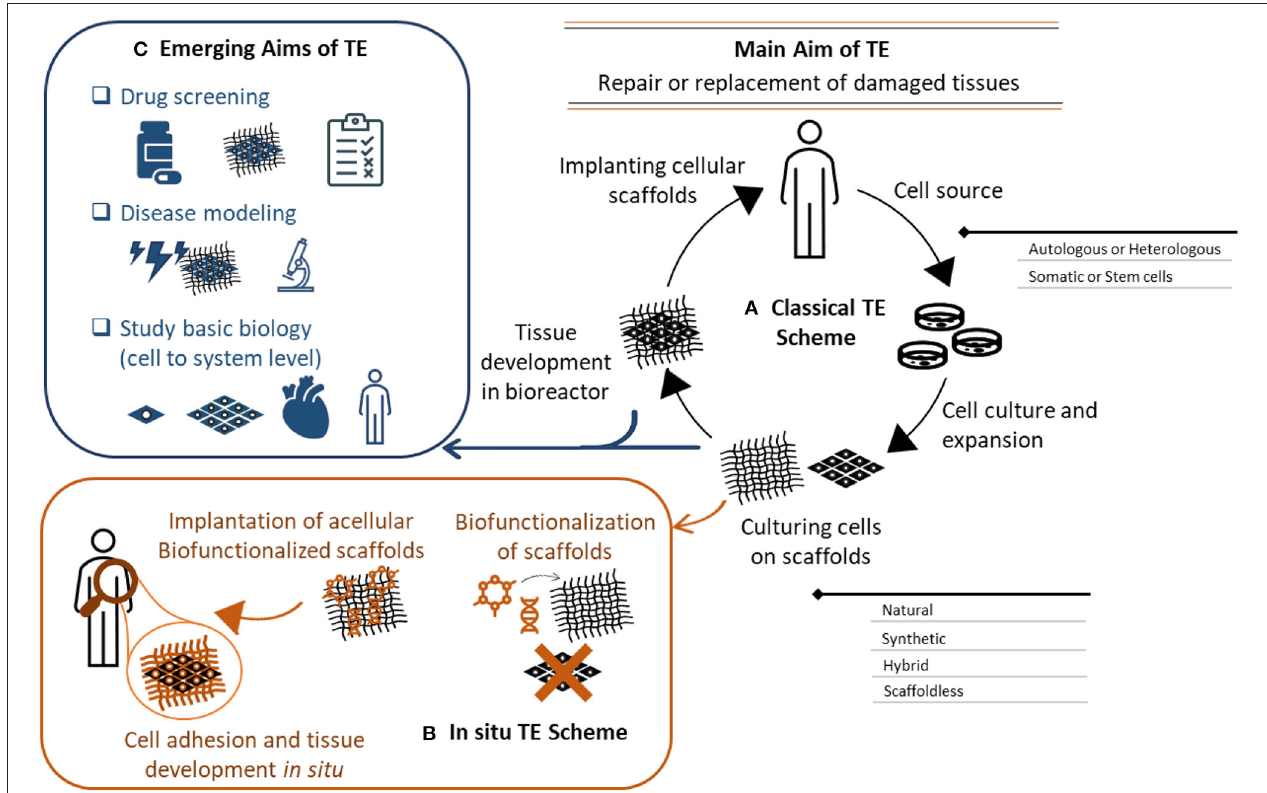
FIGURE 1 | Tissue engineering aims, concept, and evolution. (A) Classical in vitro tissue engineering (TE) relys on the use of a cell source (autologous or heterologous), cultured into a 3D scaffold. The cellular scaffold is then incubated in a bioreactor to influence cells growth, extracellular matrix secretion and subsequent tissue formation. The developed tissue is then used to replace damaged tissues. This scheme has evolved to an in-situ TE scheme (B) , where acellular scaffolds are biofunctionalized with bioactive molecules to instruct cell adhesion and tissue formation. These instructive scaffolds are implanted to induce tissue formation in situ . (C) The applications of in vitro tissue engineering also extend to drug screening, disease modeling, and cell/system biology studies. The complexity of these constructs provides a more biomimetic platform that can recapitulate the in vivo physiology of the human body. These systems also provide a better understanding of cell biology and functions from cells to systems